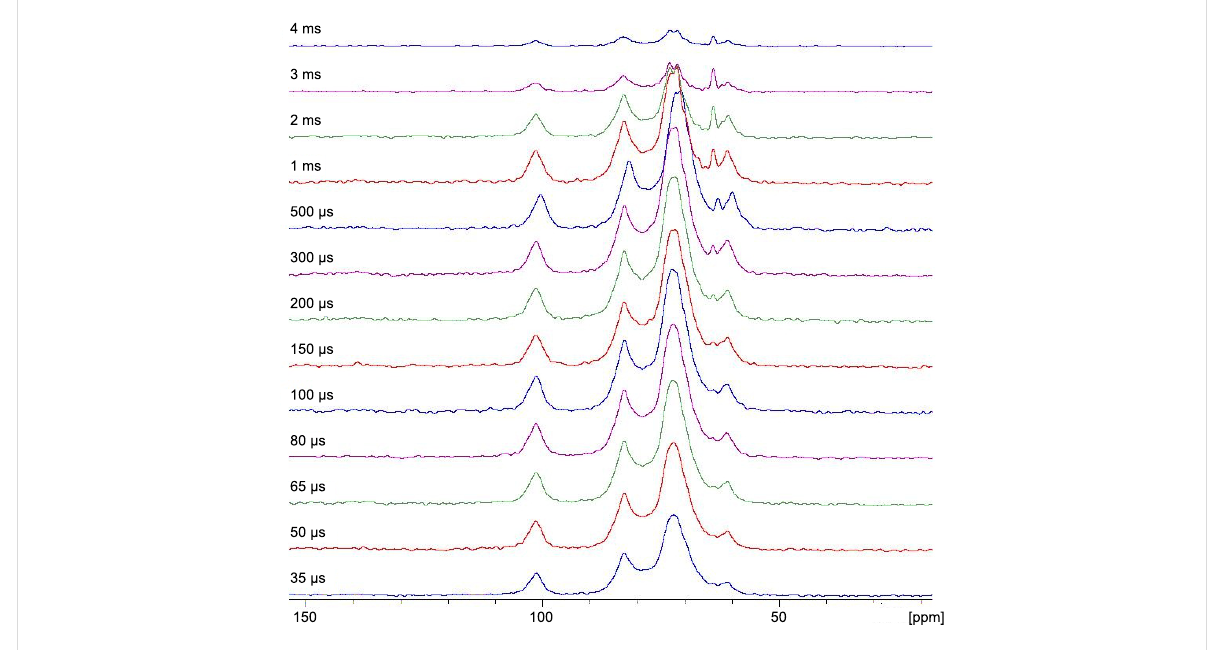
Figure 5: 1D 13 C CP/MAS spectra of polymer D3 as a function of the contact time varying from 35 μ s to 4 ms.